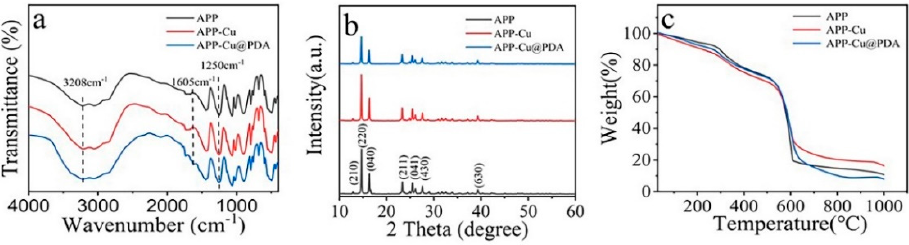
Figure 1. ( a ) FTIR spectra, ( b ) XRD patterns, and ( c ) TGA curves of APP, APP-Cu, and